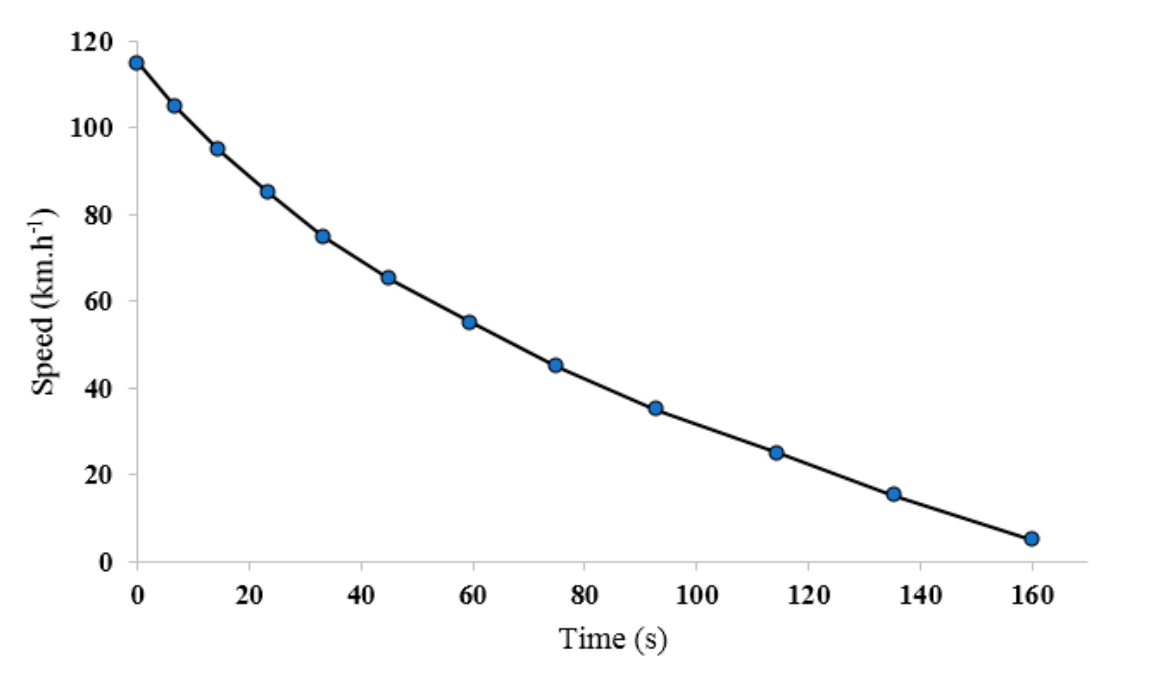
Figure 6. Kia Ceed’s coasting curve.